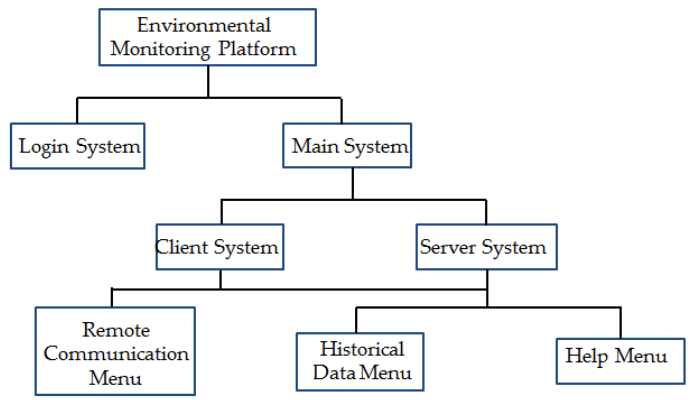
Figure 5. The structural relationship of software system.